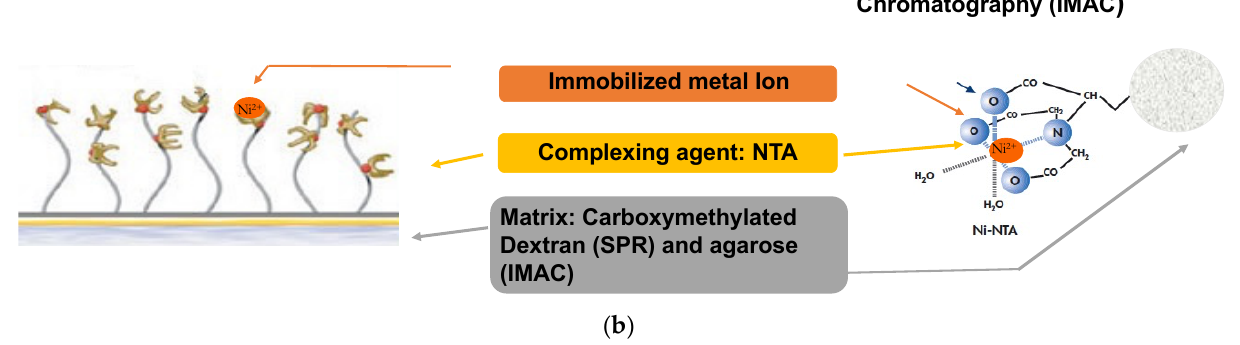
Figure 1. A simulation of Metal-Chelating peptides separation in IMAC ( a ) considering the analogy between IMAC and SPR (similar support, metal, complexing agent) ( b ). t R retention time; R max maximum Response; K D Constant of dissociation.